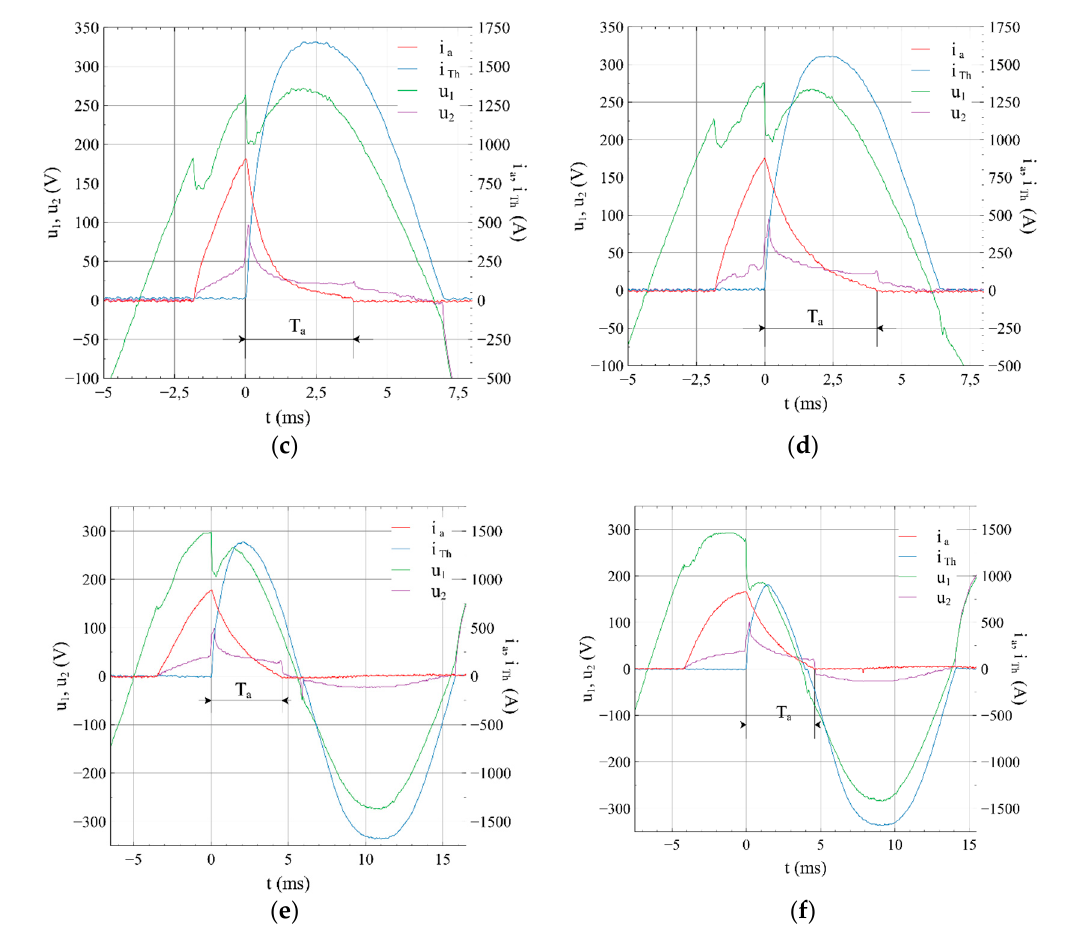
Figure 7. Current waveforms in the arc branch ( i a ) and current in the thyristor branch ( i Th ) and supply voltage ( u 1 ) and voltage measured on the arc source electrodes ( u 2 ) for various parameters of the current: ( a ) L R = 5 µH, T a = 0.7 ms; ( b ) L R = 34 µH, T a = 0.85 ms; ( c ) L R = 76 µH, T a = 3.8 ms; ( d ) L R = 160 µH, T a = 4.1 ms; ( e ) L R = 286 µH, T a = 4.6 ms; ( f ) L R = 426 µH, T a = 4.6 ms.